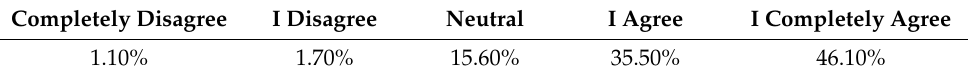
Table 8. Obtained values of classifying the opinion of other descriptions.